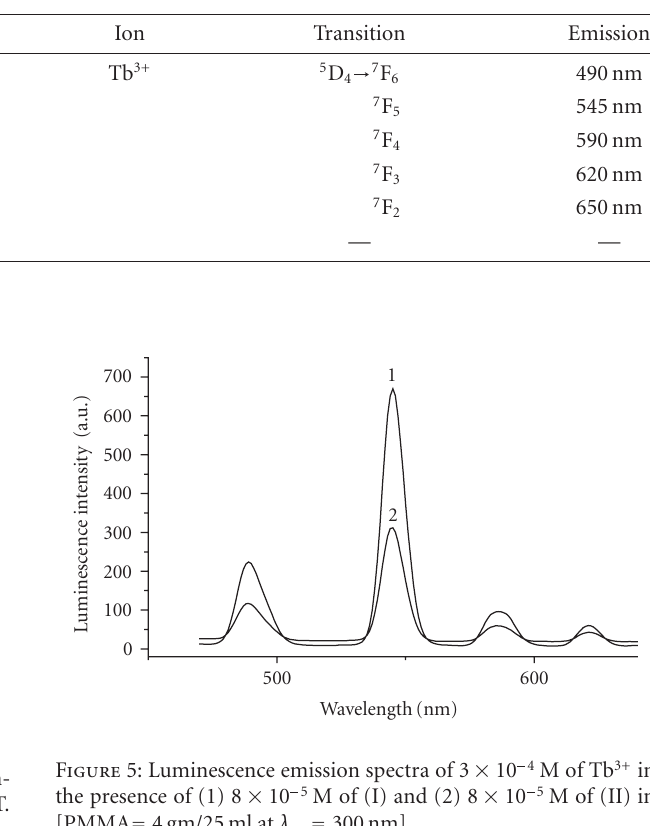
Table 2: The typical emission bands of the lanthanide ions Eu 3+ and Tb 3+ in solution.